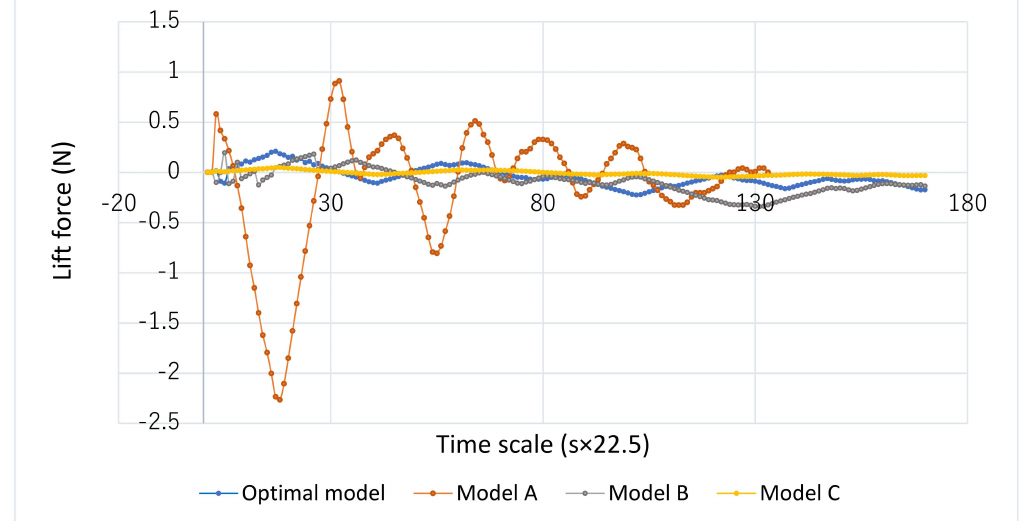
Figure 19. Lift Force Plots for the Optimal Model and Models A, B and